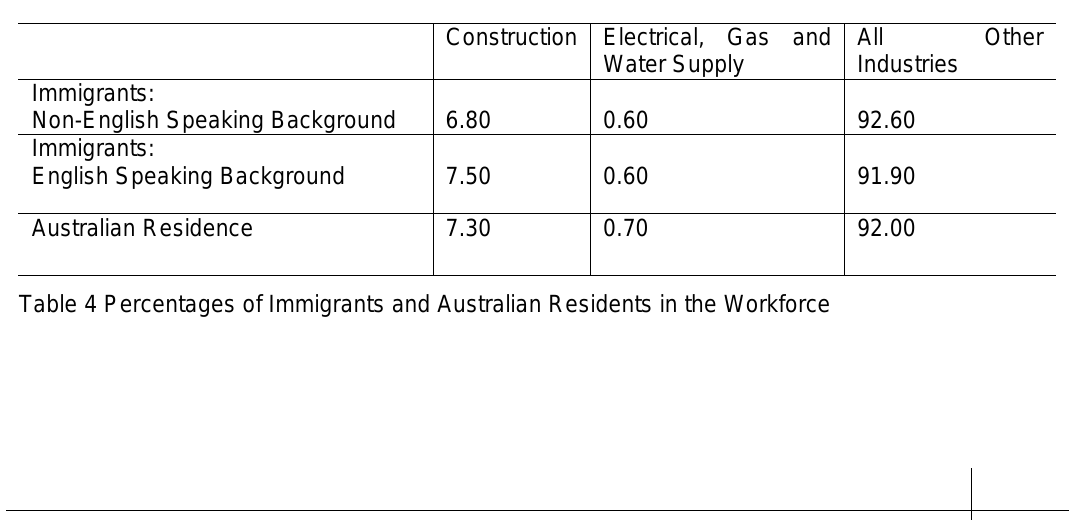
Table 3 Qualifications of Immigrants and Australian Residents (total %)